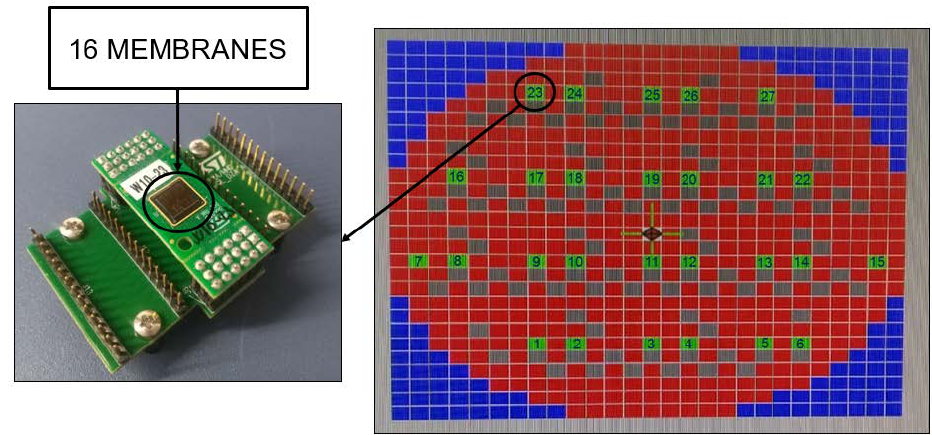
Figure 1. View of the 4 × 4 array of circular transducers ( left ); position of the sample on the wafer map ( right ).